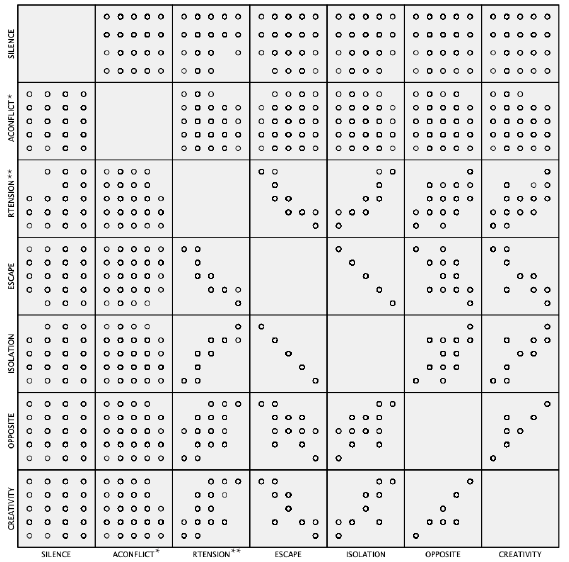
Figure 1. Scatterplot for constructs (source: created by